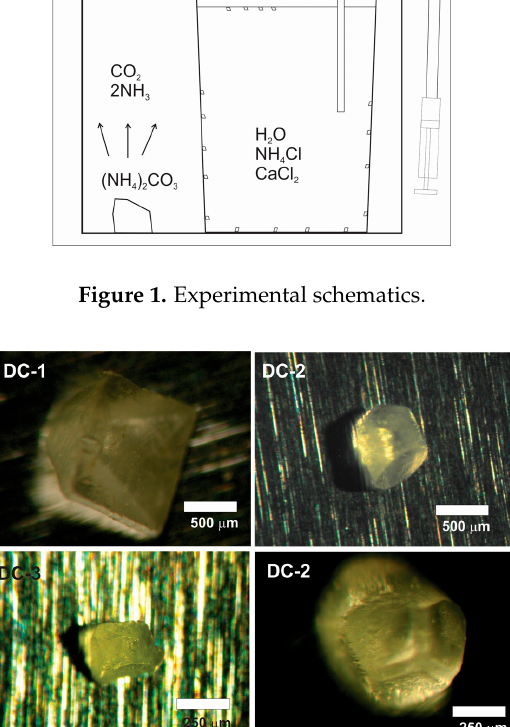
Figure 2. Optical micrographs of individual crystals from experiments DC-1, DC-2, and DC-3. The crystal plane that was in contact with the beaker wall is exposed in all images except DC-2 (lower), in which the crystal side opposite to crystal/beaker boundary is exposed.